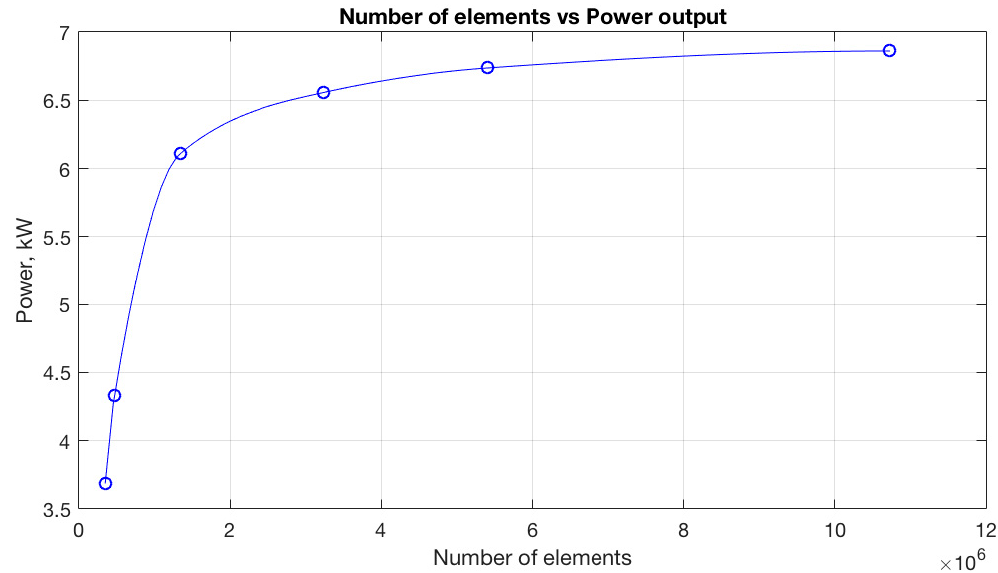
Figure 12. Mesh convergence analysis.